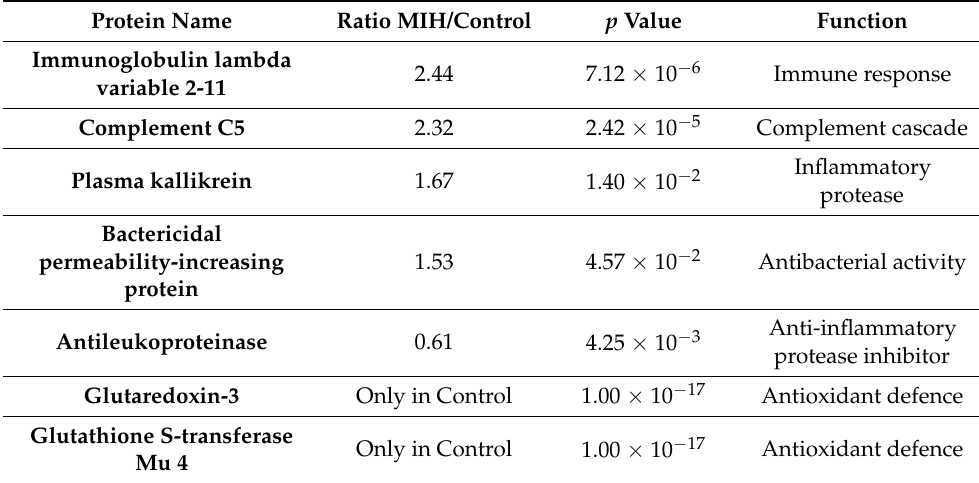
Table 2. Selected deregulated proteins with information on statistical significance ( p values), expres- sion (ratio MIH/Control), and function.